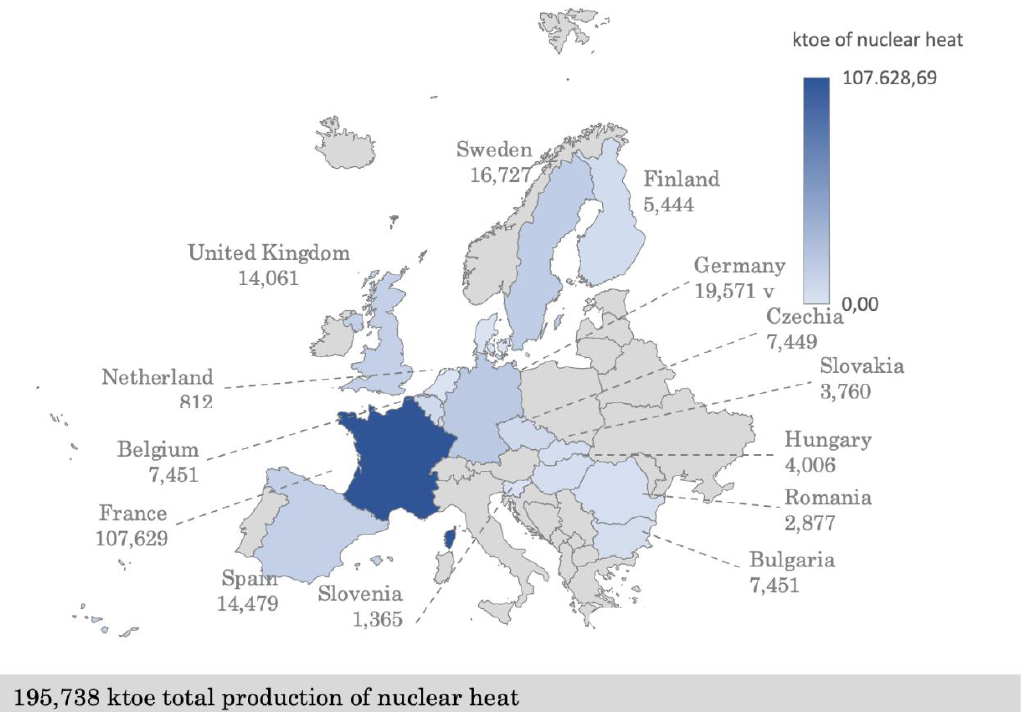
Figure 11. Nuclear energy in the EU—data for 2018. Source: Eurostat.